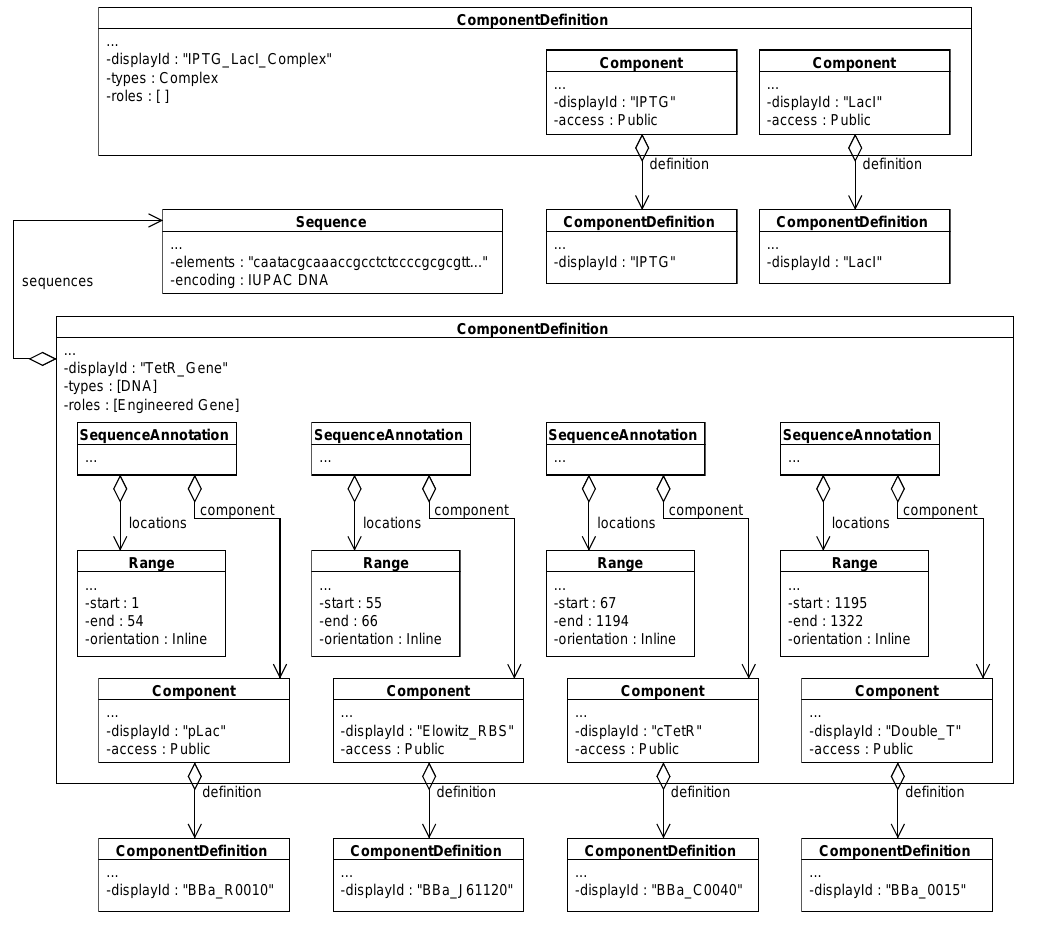
Figure 30: Composite ComponentDefinition objects for the LacI inverter. In the case of the ComponentDefinition that represents the TetR gene, its sub- Component objects are located as Range s along its Sequence using SequenceAnnotation objects. The ComponentDefinition that represents the IPTG-LacI complex, however, has no Sequence and its sub- Component objects are composed without any data about their relative